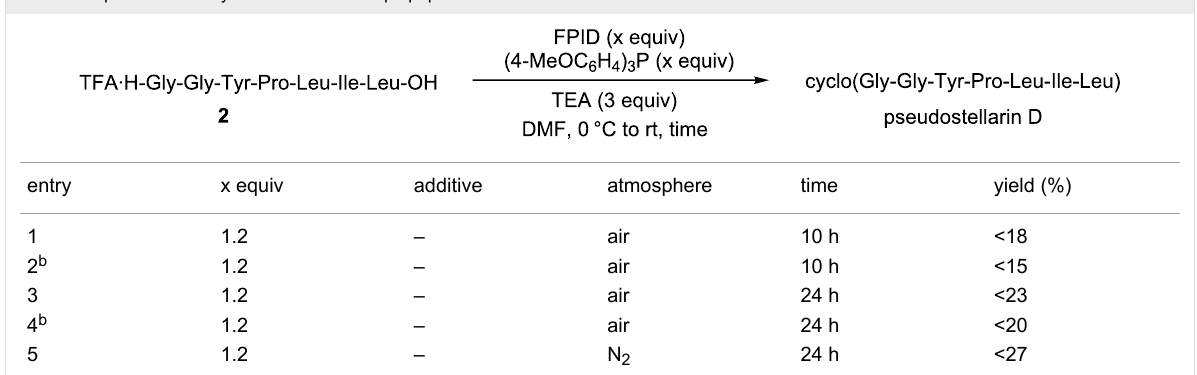
Table 2: Optimization of cyclization of linear heptapeptide 2 .